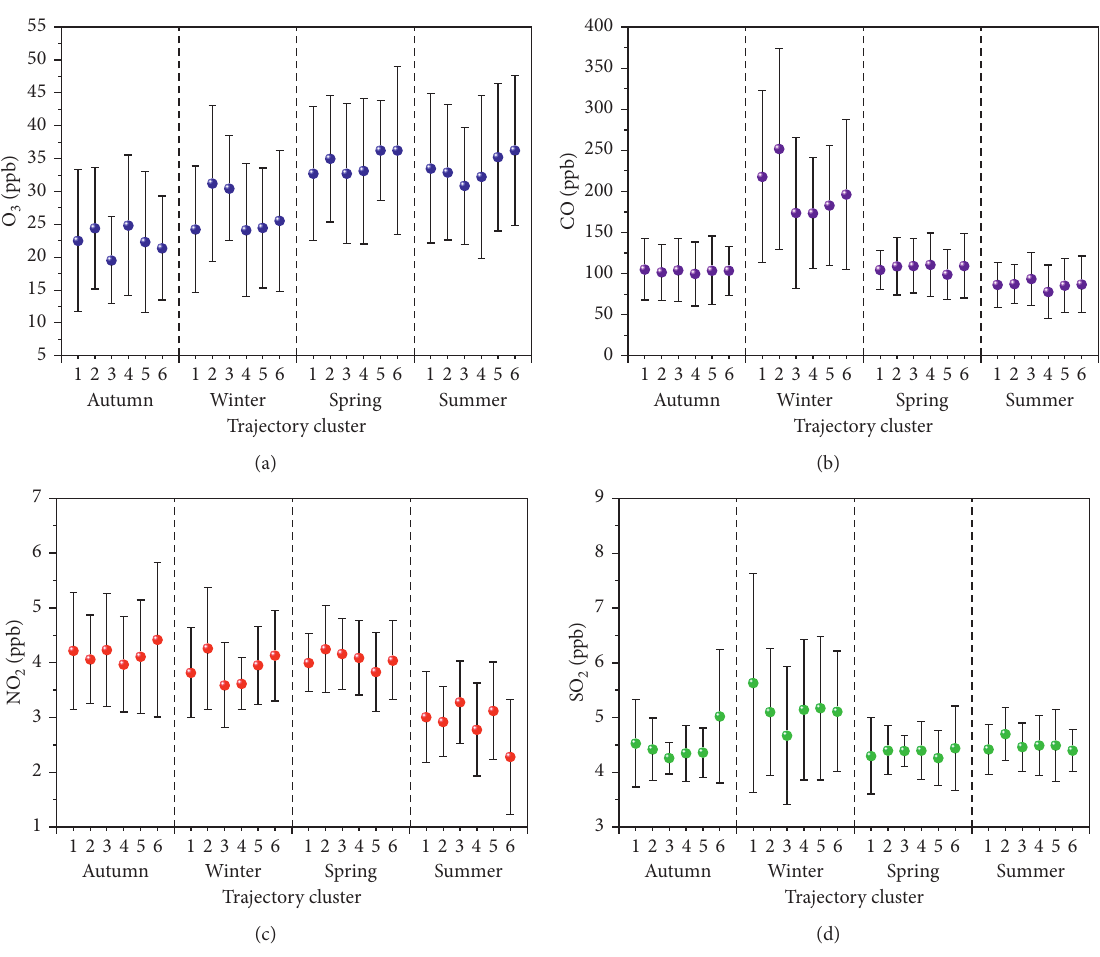
Figure 7: Average mixing ratios (O 3 , CO, NO 2 , and SO 2 ) associated with the six trajectory clusters on a seasonal basis. The solid circle indicates the arithmetic mean, and the line is the standard